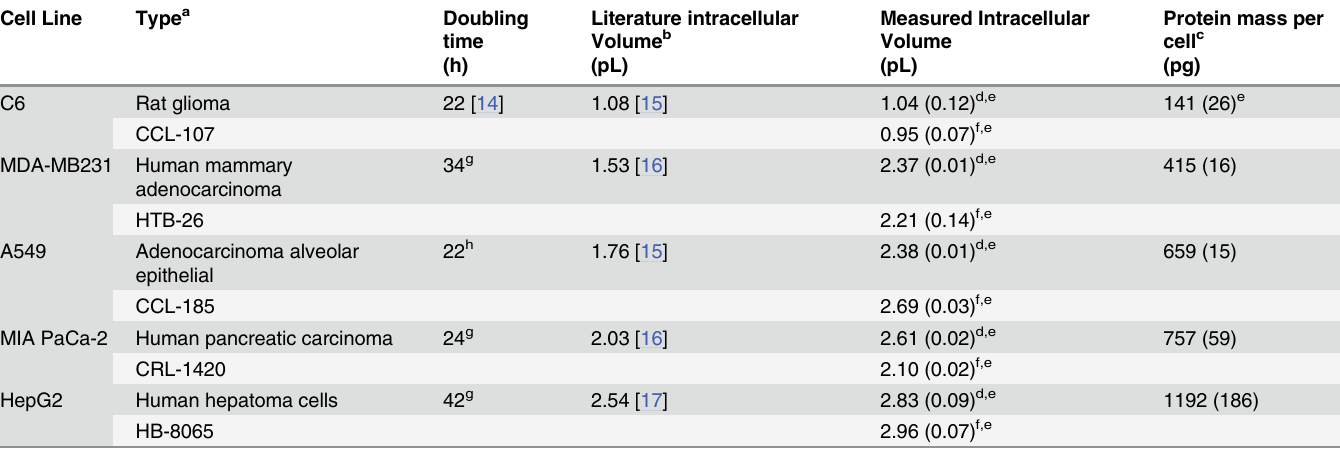
Table 1. Physical and biological parameters of cell lines